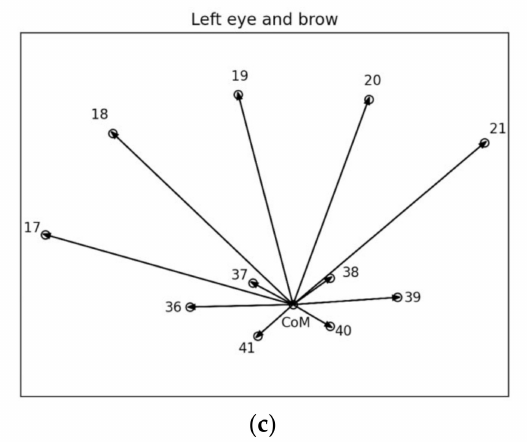
Figure 2. ( a ) 68 facial landmarks points. ( b ) The unit vector defined along the nose from landmark point 27 to landmark point 30. The first three primary vectors are also shown from landmark point 27 to the centers of the eyes and mouth, respectively. ( c ) Secondary vectors from the center of the left eye (primary point) to (secondary) landmark points on the left brow and left eye